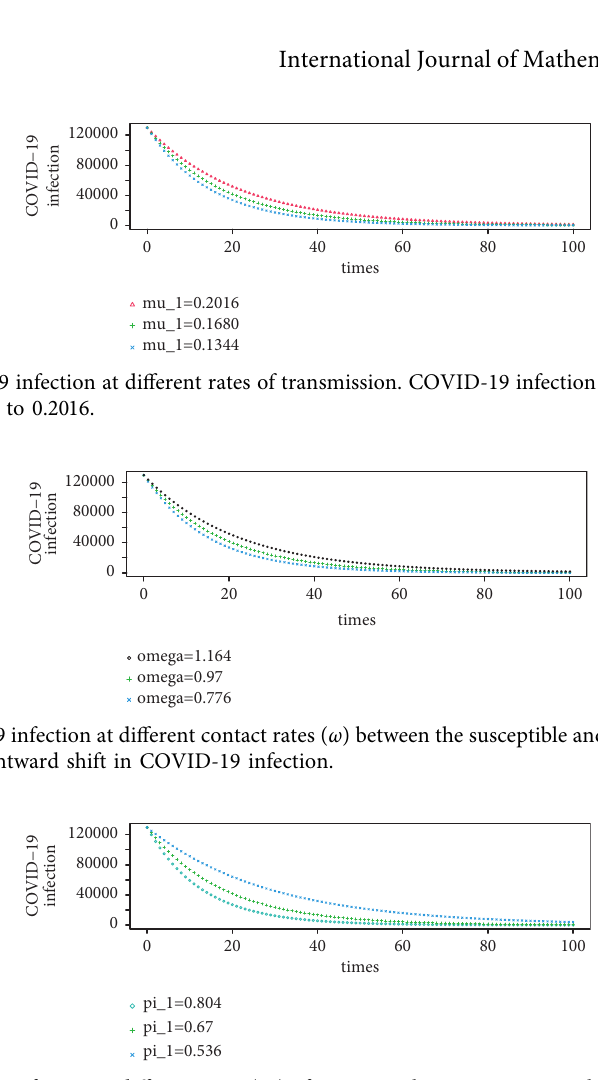
increases from 0.536 to 0.67 and 1